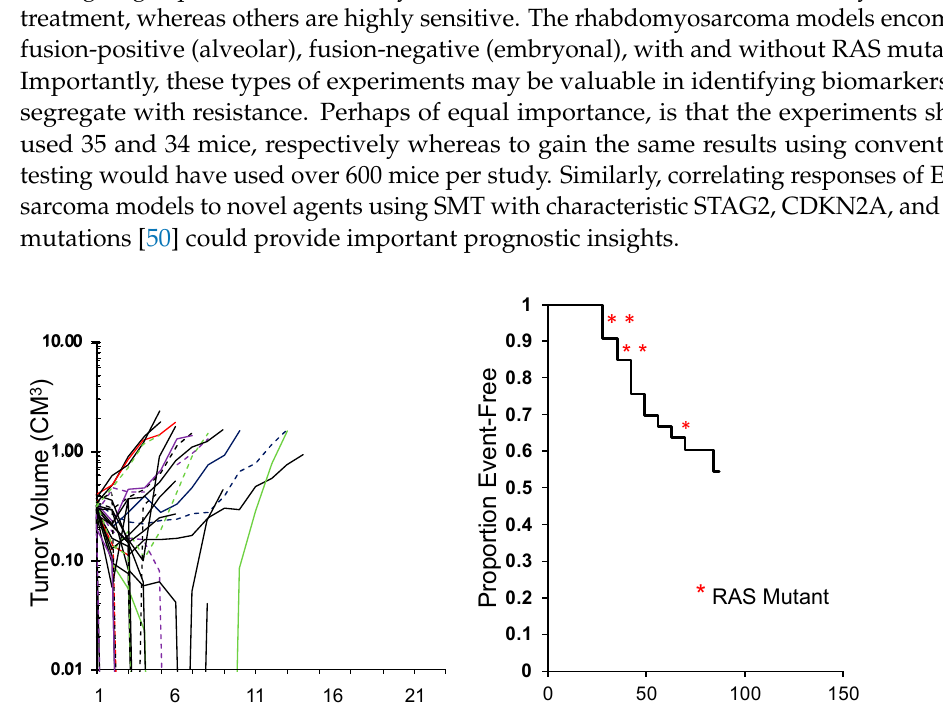
6 of 11 Figure 3. SMT evaluation of trastuzumab-deruxtecan (DS-8201a). Left : Tumor volume response